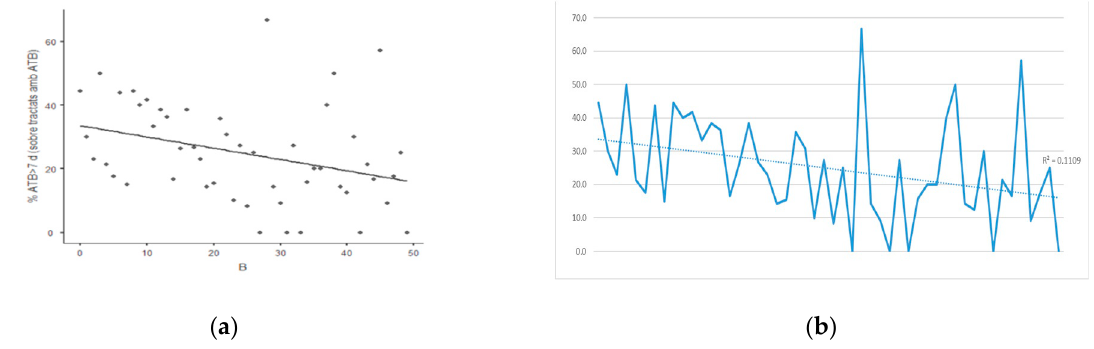
Figure 1. ( a ) Scatterplot (rho = − 0.38) and ( b ) Temporal evolution of the percentage of patients on antibiotic treatment with duration over 7 days for the whole study period (R 2 = 0.111).